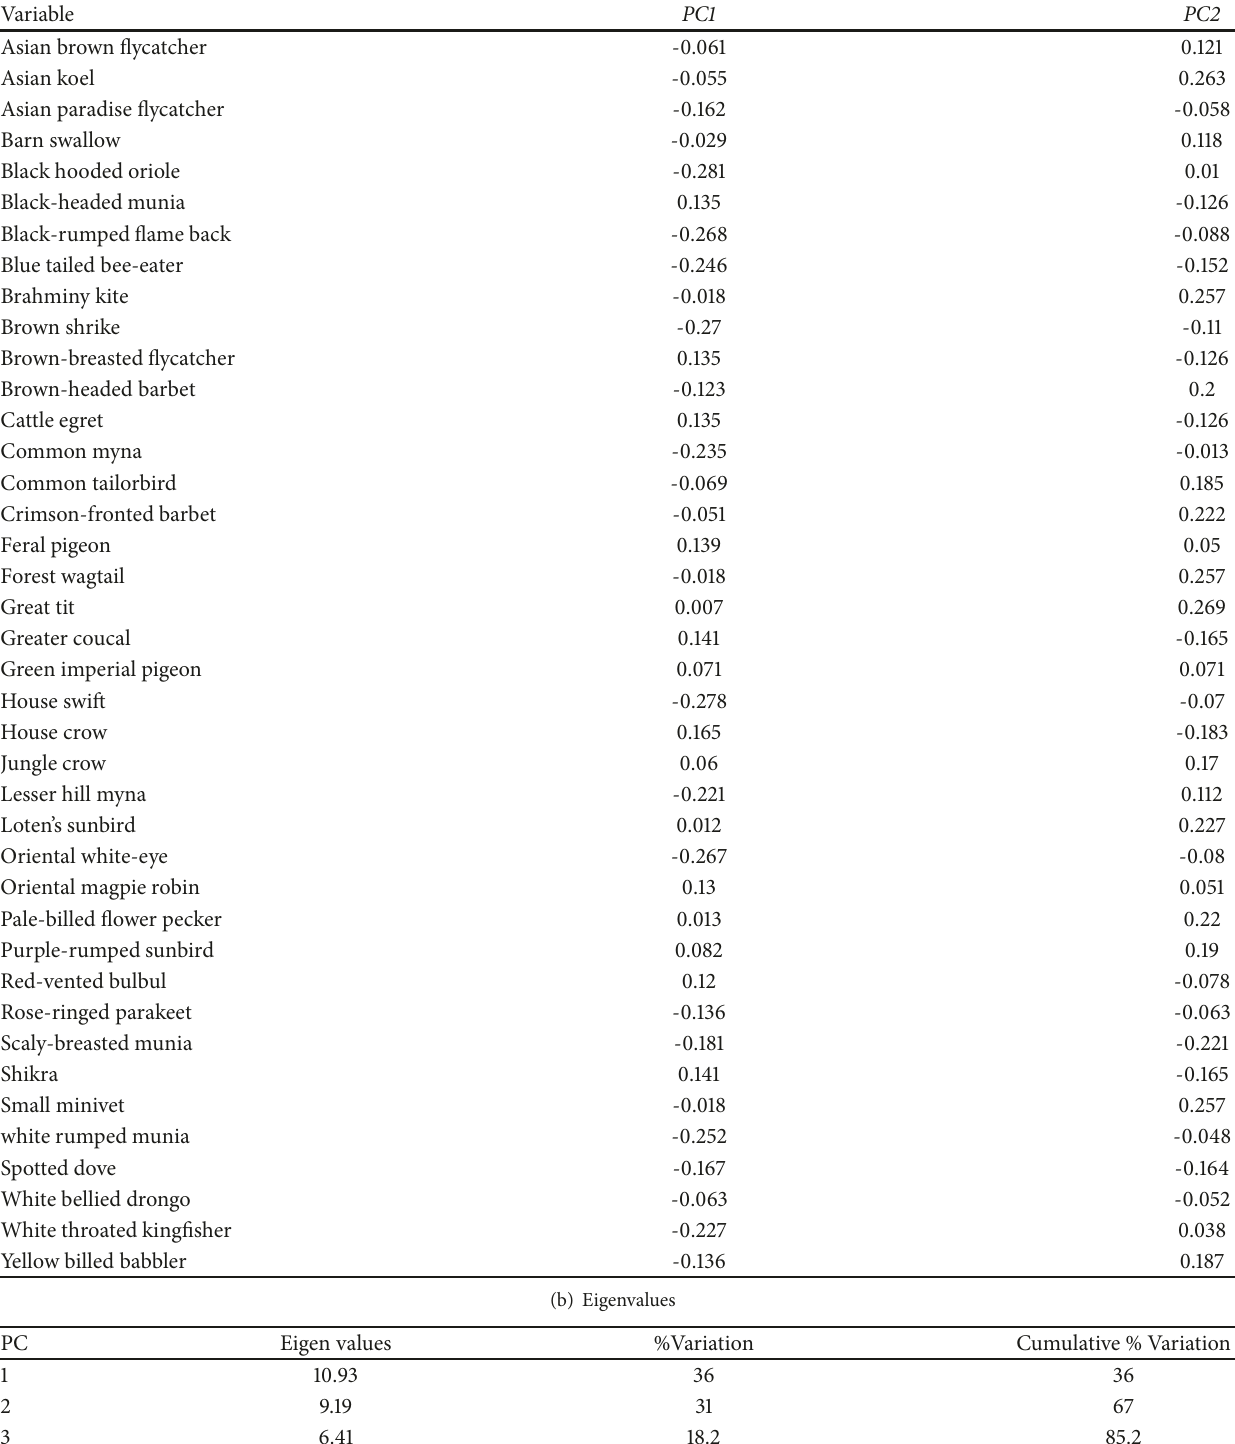
Table 4: Final output of the PCA of abundance of birds’ species recorded in different habitat types in University of Kelaniya. Cumulative % variations of only the PC1 and PC2 are shown. A considerable cumulative percentage as 67% of the total variation among abundance of bird species is explained by PC1 and PC2